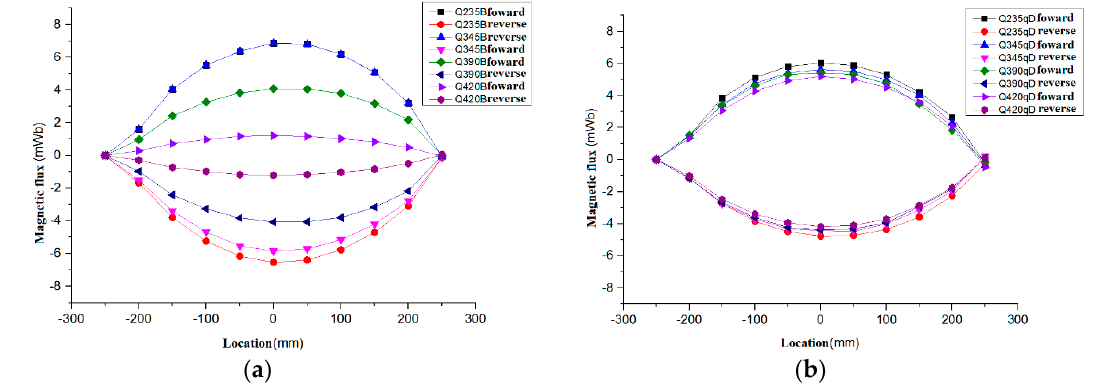
Figure 6. Magnetic flux of structural steels with a diameter of 32 mm. ( a ) Magnetic flux of building structural steel specimen, ( b ) Magnetic flux of Bridge structural steel